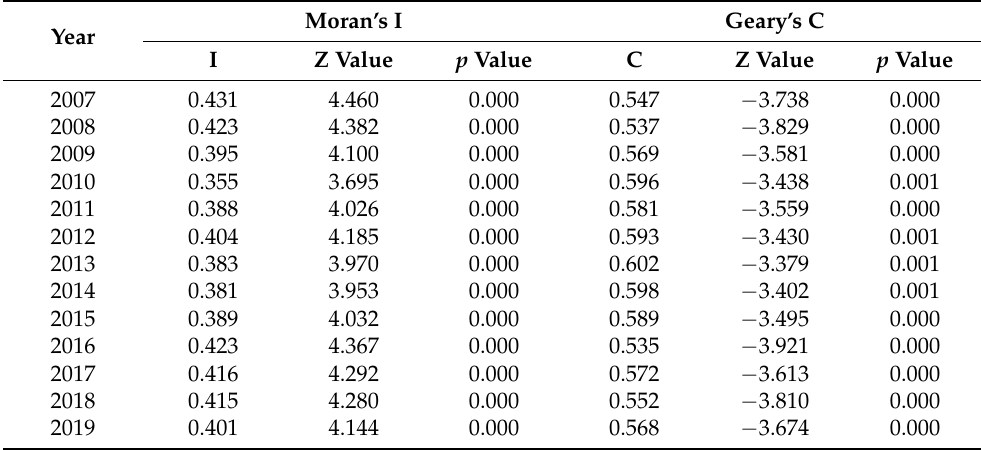
Table 1. Moran’s I and Geary’s C based on the distance weighting